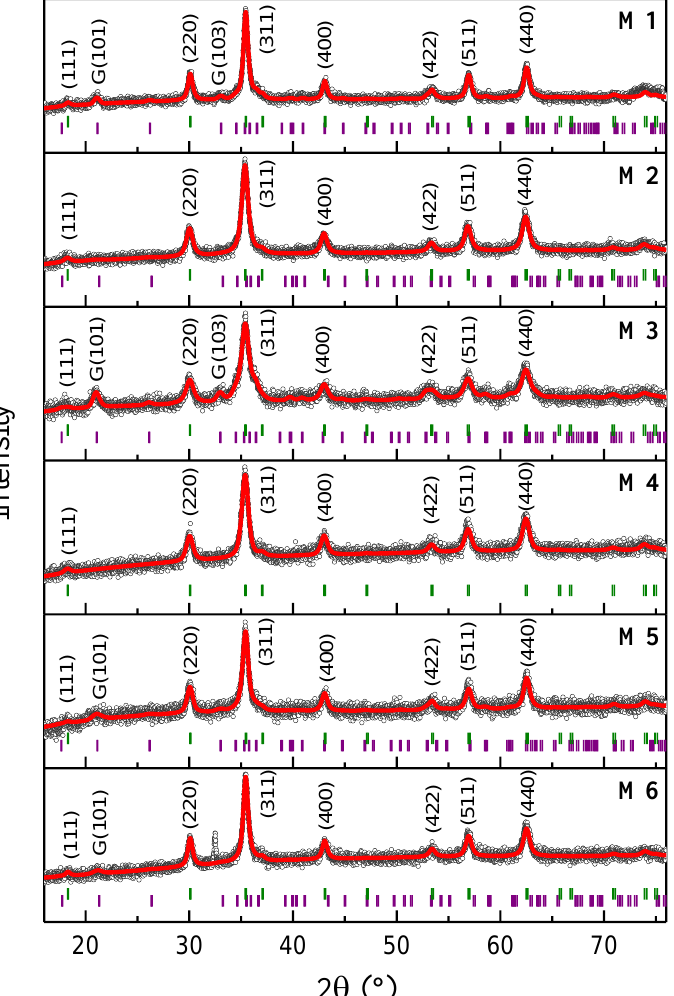
Figure 1. Rietveld refined XRD patterns of the M1 – M6 samples. Black circles are the experimental data, red lines indicate calculated XRD pattern, and olive and purple vertical lines represent the Bragg positions of the γ -Fe 2 O 3 and α -FeOOH phases, respectively.